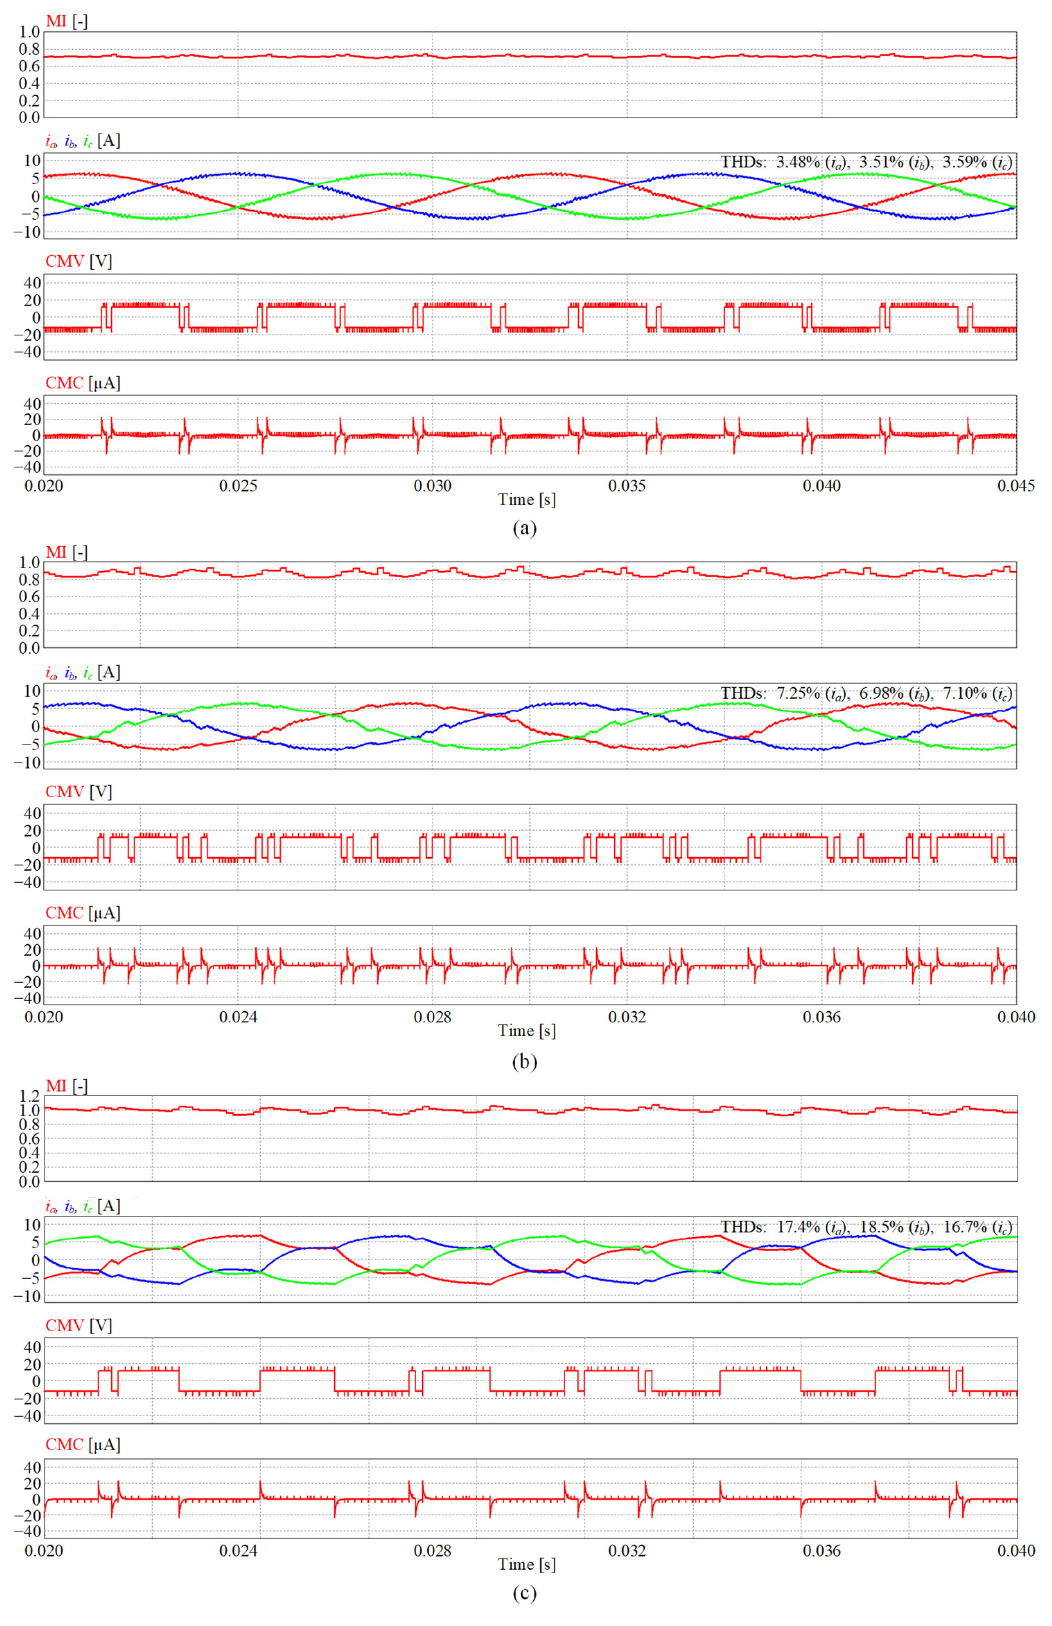
Figure 15. Simulation results of proposed method at high MI: ( a ) At rotor speed of 1000 rpm (MI = 0.7); ( b ) At rotor speed of 1200 rpm (MI = 0.9); ( c ) At rotor speed of 1400 rpm (MI = 1.0).